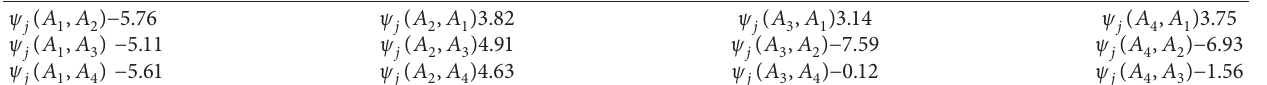
Table 9: Prospect dominance degrees.